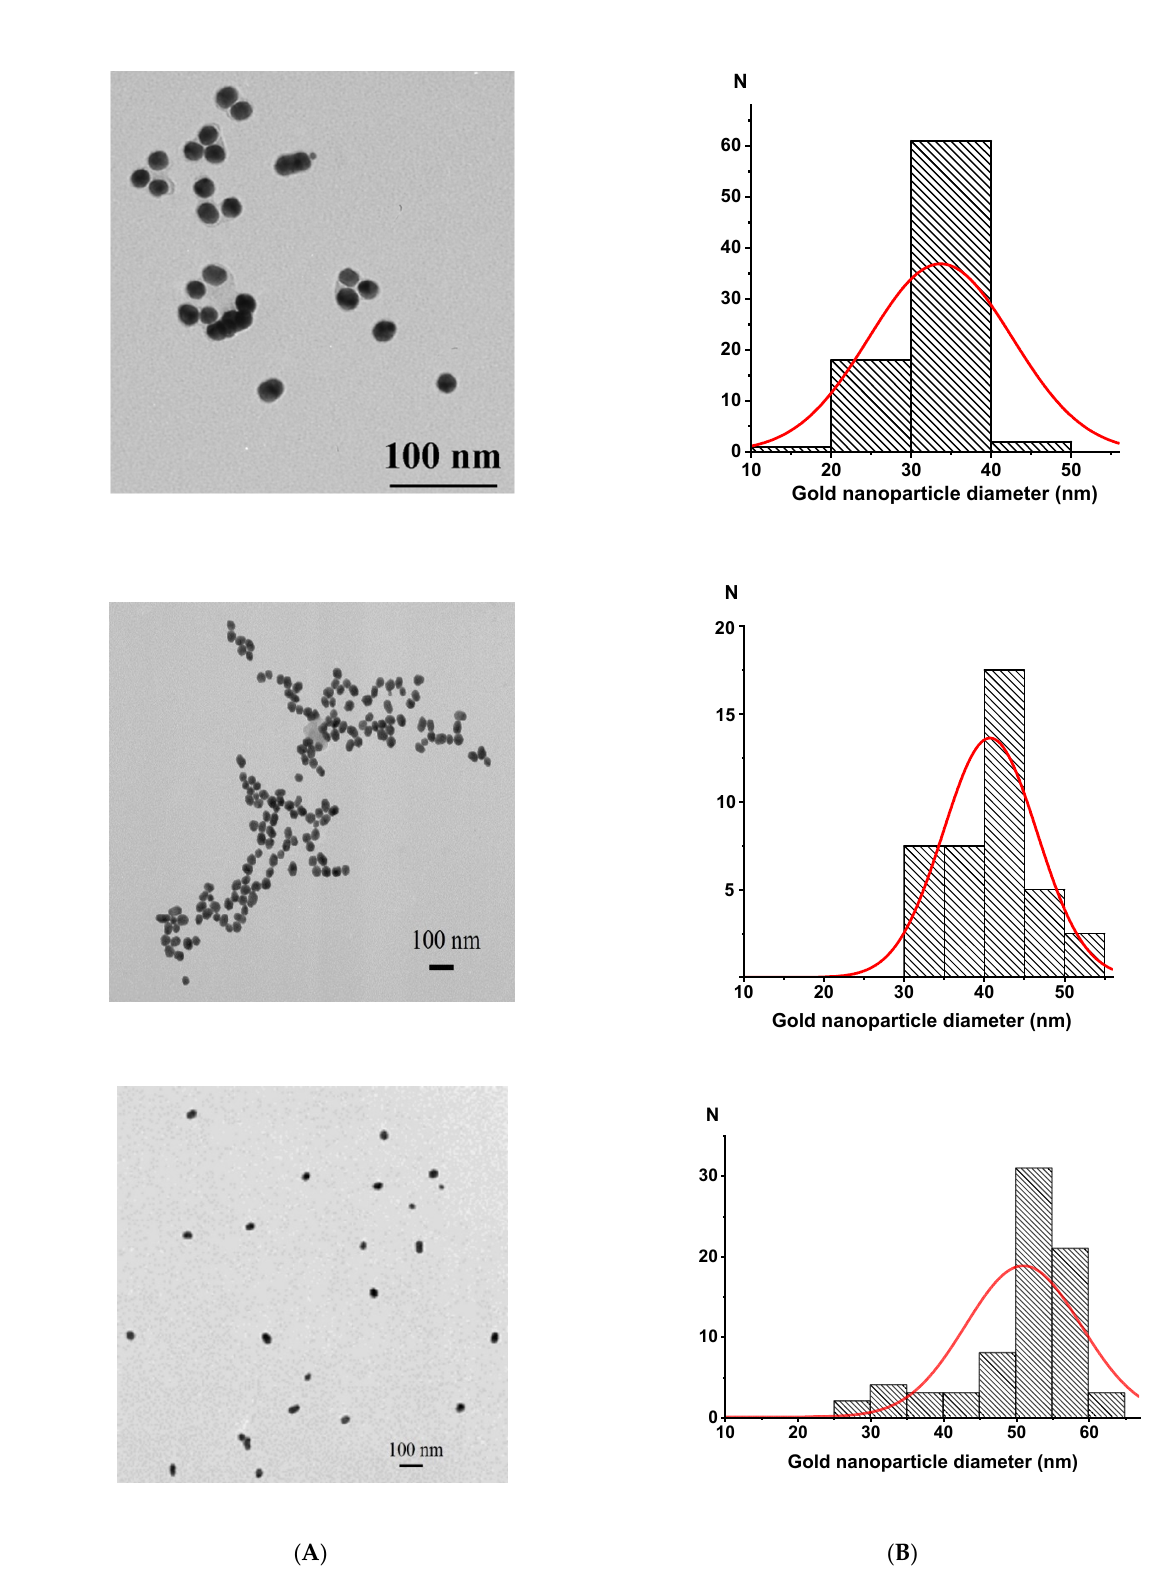
Figure 2. Electron micrographs ( A ) of preparations GNP1 ( 1 ), GNP2 ( 2 ), GNP3 ( 3 ), GNP4 ( 4 ), GNP5 ( 5 ), and GNP6 ( 6 ) and diameter distribution histograms ( B ). Sample sizes (N) were 60–90.